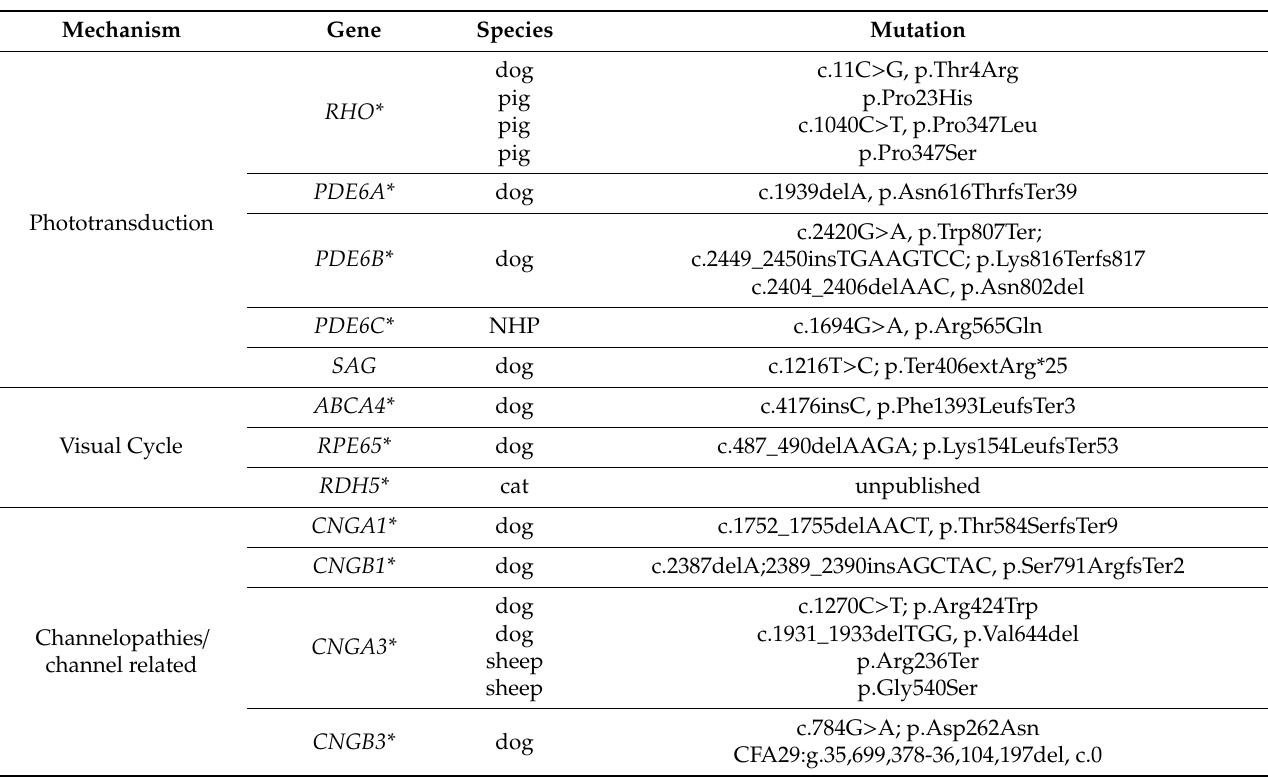
Table 1. List of mutations in large animal models of inherited retinal disease. Detailed information for some genes (indicated with*) are displayed in the text, highlighting the role of large animal models in advancing the understanding of the disease mechanism and / or providing insights into normal protein structure and function. References are available in Supplementary Material Table